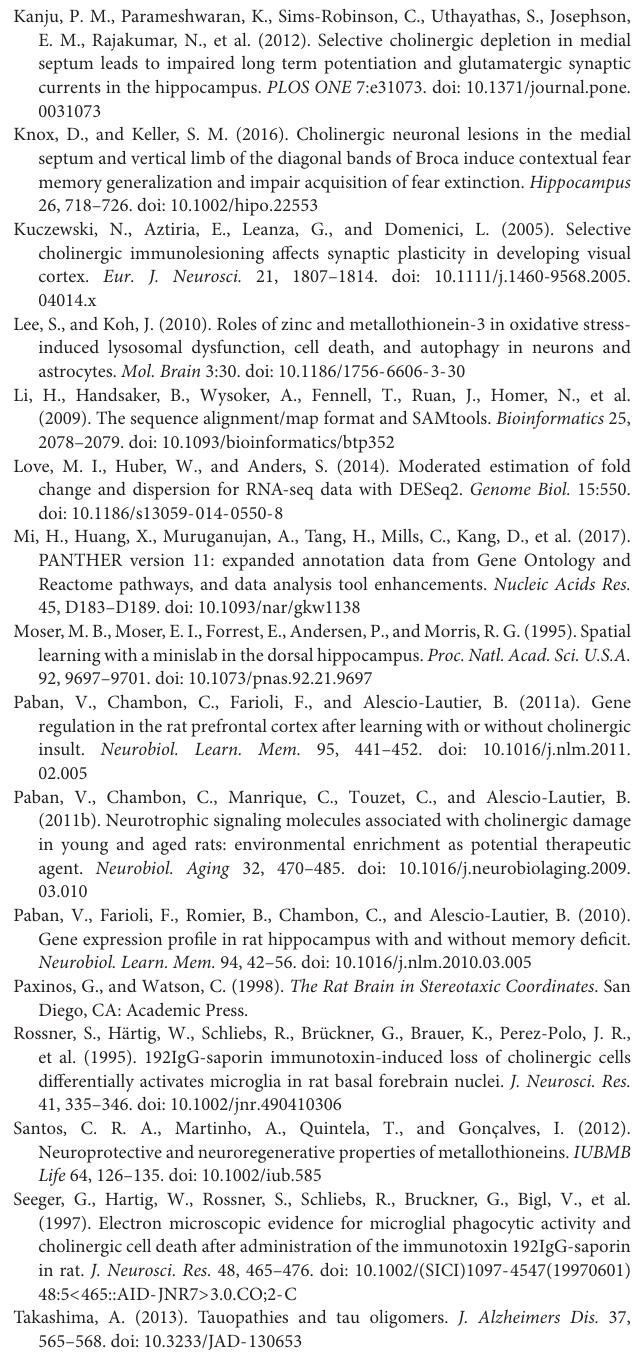
FIGURE S3 | Immunocytochemical staining of cholineacetyltransferase (ChAT) in the control and Ig-saporin-treated animals (A) . The results of counting of ChAT-positive neurons in the septum and diagonal band of Broca (B) . Differences between the control and experimental animals are significant in both structures (Student’s t -test, P < 0.05). TABLE S1 | Differential expression of genes between the dorsal and ventral hippocampus of control rats. The data are presented as ratio DH/VH; “ + ” means higher expression in the dorsal